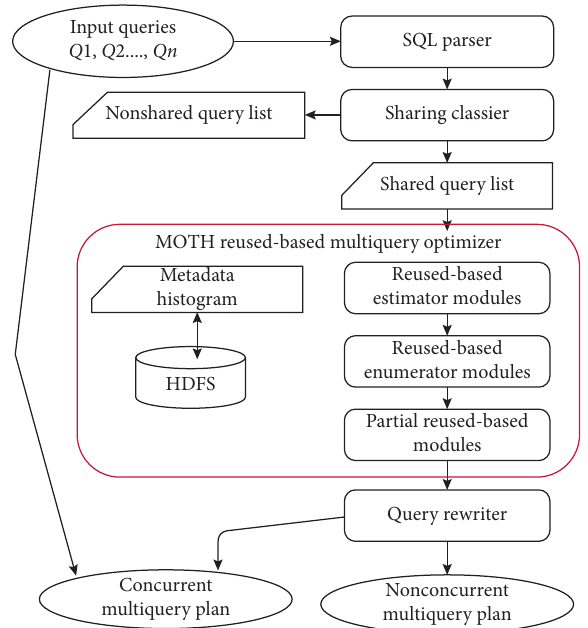
Figure 3: The MOTH system architecture